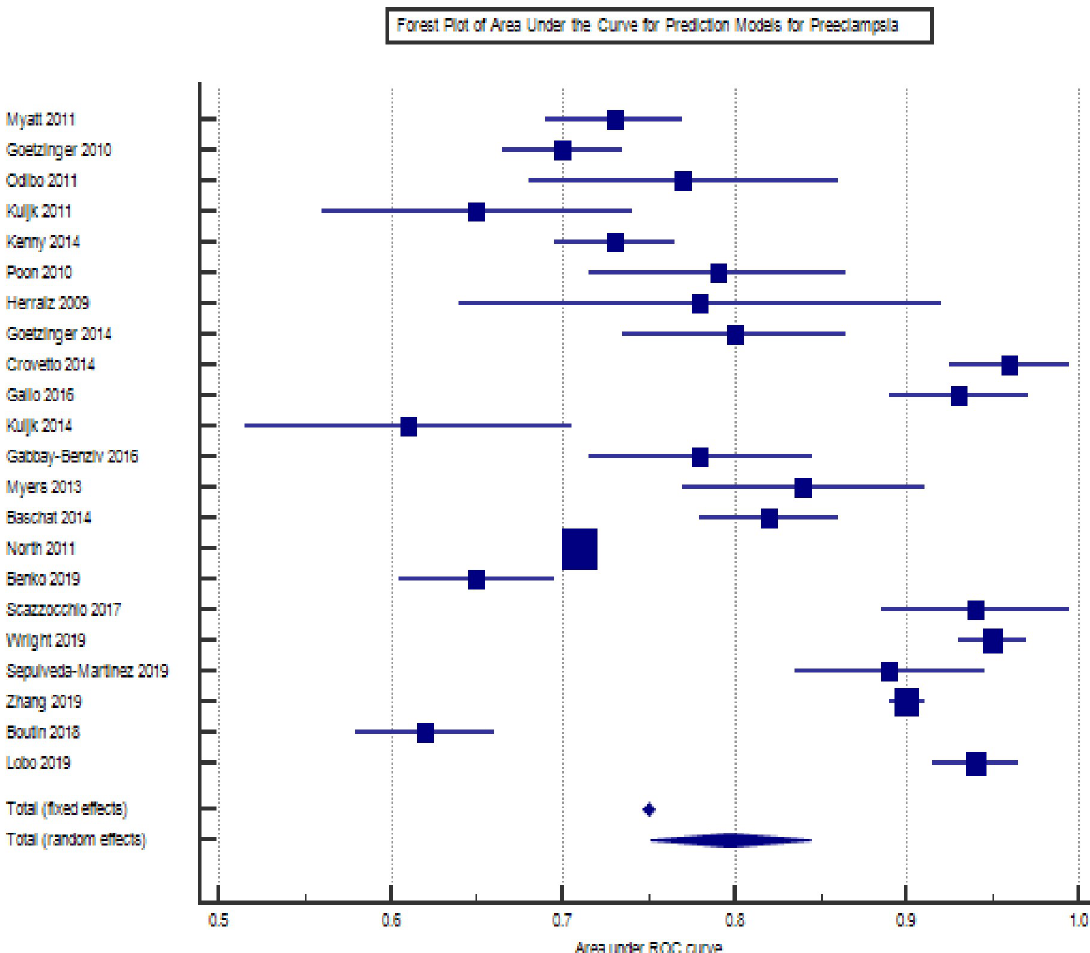
Fig 4. Forest plot of prediction models for